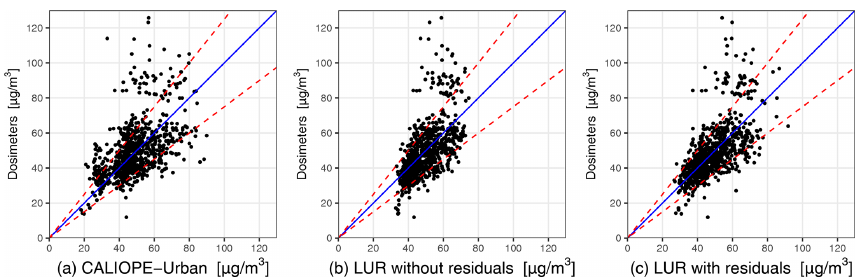
Figure 5. (a) Raw annual mean of CALIOPE-Urban NO 2 concentrations, (b) microscale LUR model results, without the interpolated residuals, and (c) microscale LUR model results, with the interpolated residuals, versus the annualized passive dosimeter campaigns. These figures use the test sets in which the performance of the microscale LUR model has been assessed. The dashed red lines report passive dosimeter uncertainty ( ± 25%), and the identity line is represented in blue. The statistical results are shown in Table 2.